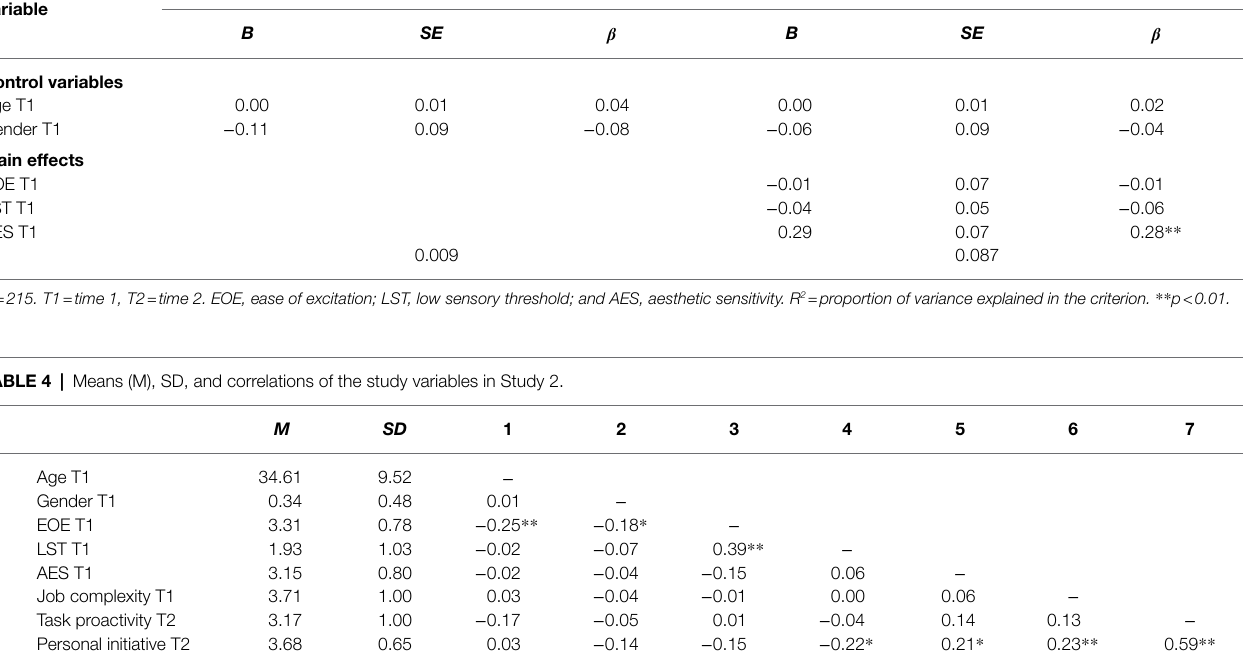
TABLE 3 | Results of the hierarchical multiple regression analysis with personal initiative at T2 as dependent variable (Study 1).